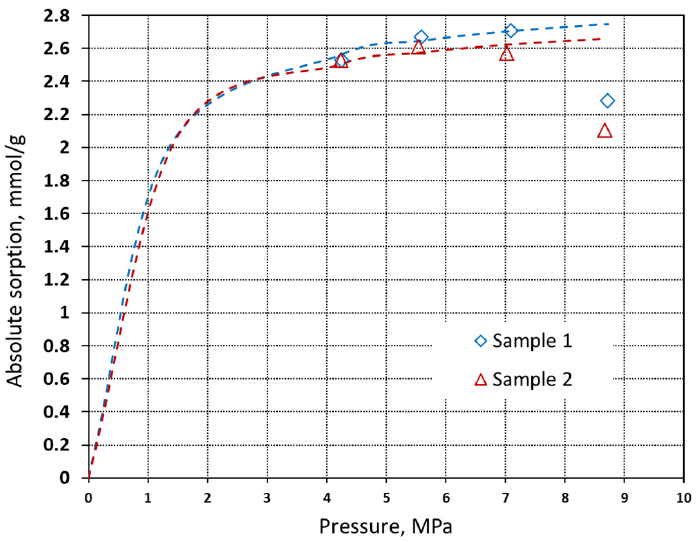
Figure 8. Absolute sorption isotherms of carbon dioxide on pyrolyzed spruce wood at 40 °C with the Langmuir model fitted (dashed line).